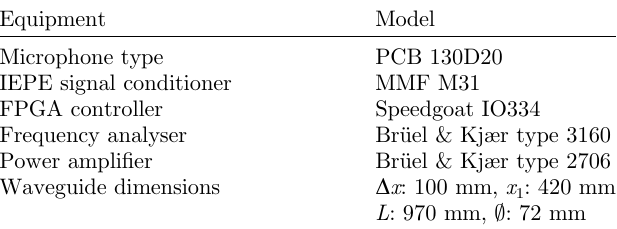
Table 2. Experimental setup equipment list.